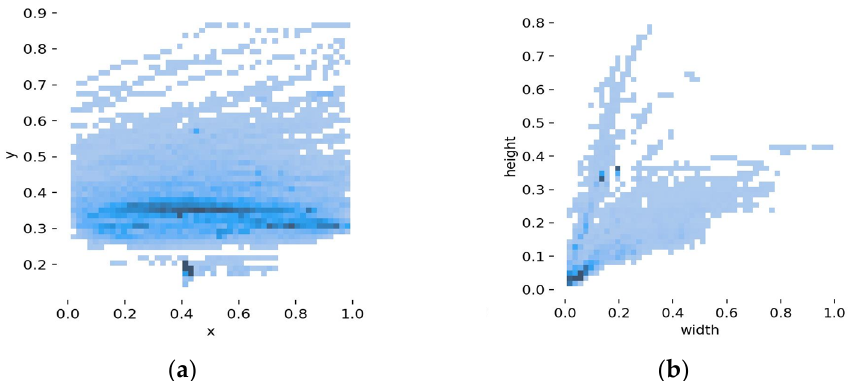
Figure 7. ( a ) Distribution of position of all annotations; ( b ) Heatmap of the annotation size.